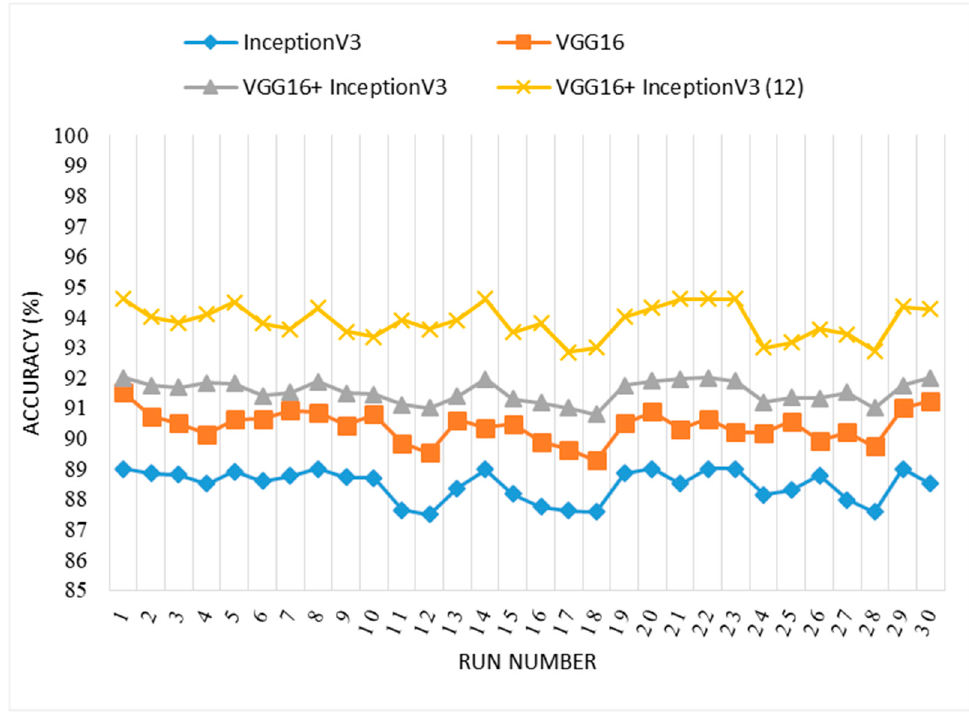
Figure 7. The thirty data samples of accuracies for each model in the statistical analysis.